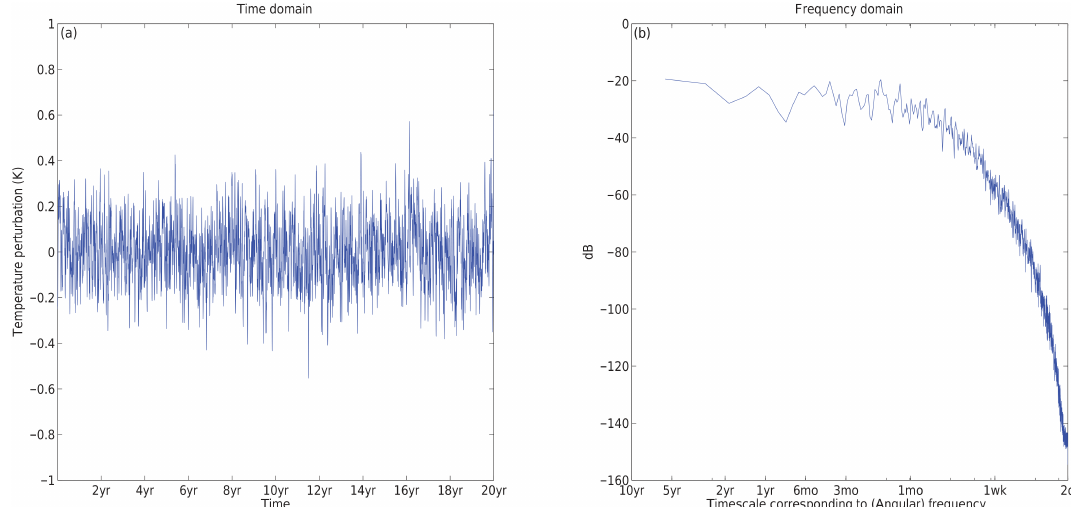
Figure 3. Time domain (left) and frequency domain (right) representations of one of the 22 sequences used in this study to perturb temperature (see Sect. 3.1). The sequences are low-pass-filtered white noise with a cutoff frequency corresponding to a timescale of 1